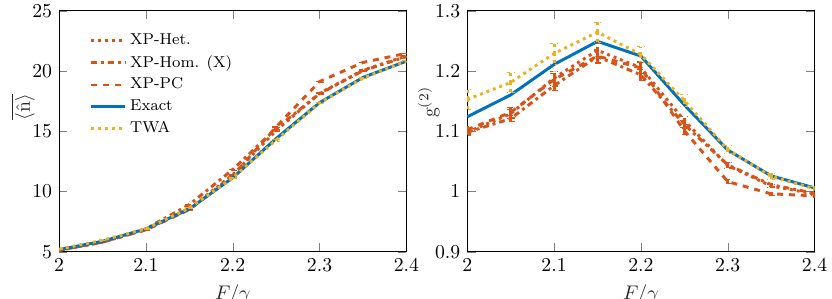
Figure 2. Stationary ensemble expectations of photon number ( left ) and second-order correlation ( right ) as a function of F through the bistability regime for parameters U / γ = 0.05, ∆ / γ = 1. Results were obtained by averaging over 10 4 samples after t = 100 γ − 1 of evolution from the vacuum. The exact solution is the analytical result from